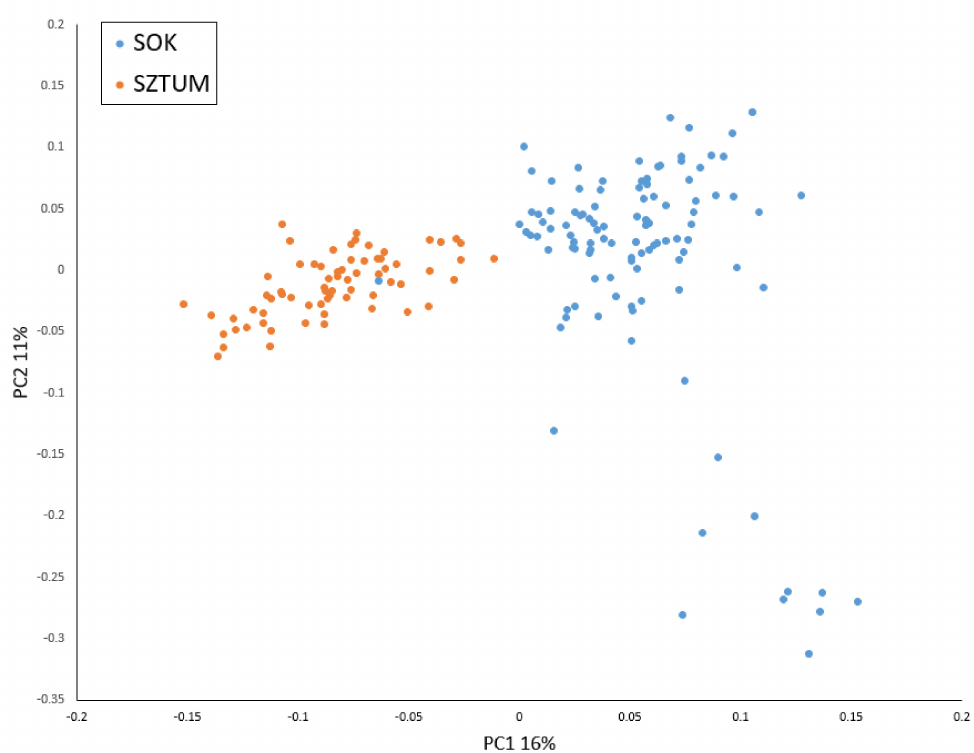
Figure 2. Principal components analysis based on single nucleotide polymorphism SNP genotypes. SOK: Sok ó lski and SZTUM: